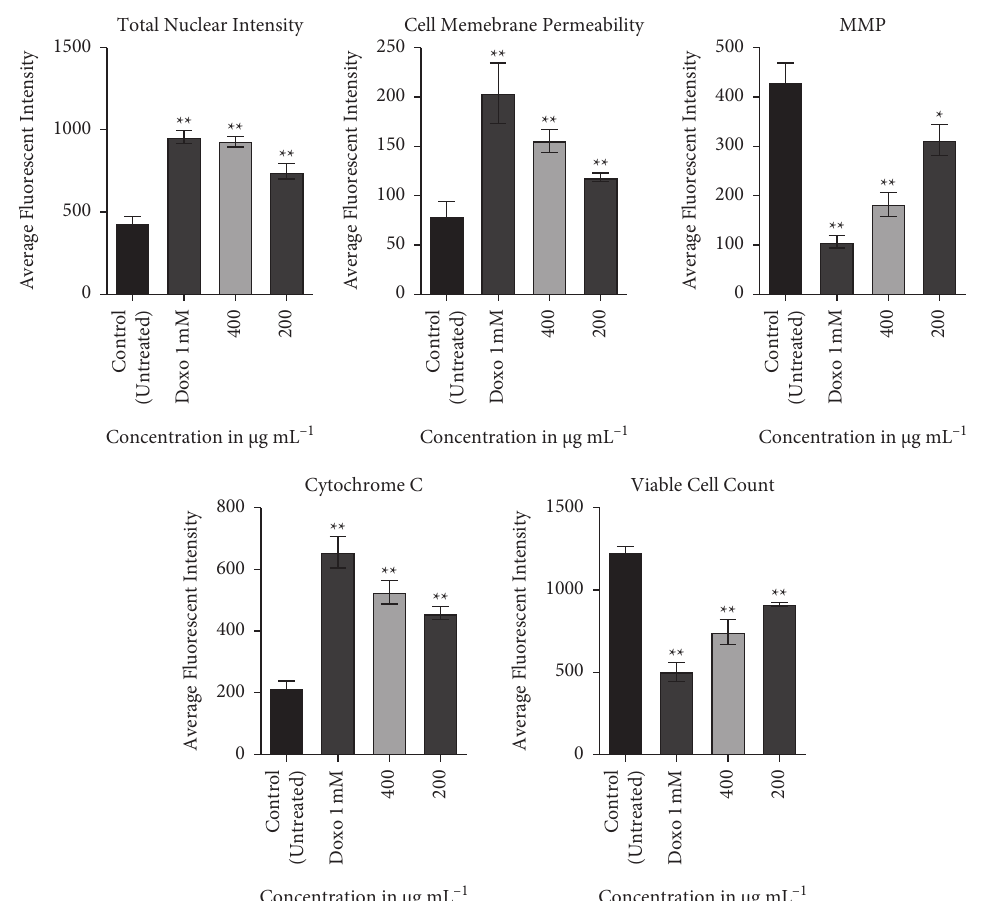
Figure 14: Effects of the NPs synthesized under the presence of magnetic field at 60 mJ/cm 2 against A549 cells. The effects were assessed using the ArrayScan HCS Reader; ∗ P ≤ 0.05; ∗∗ P ≤